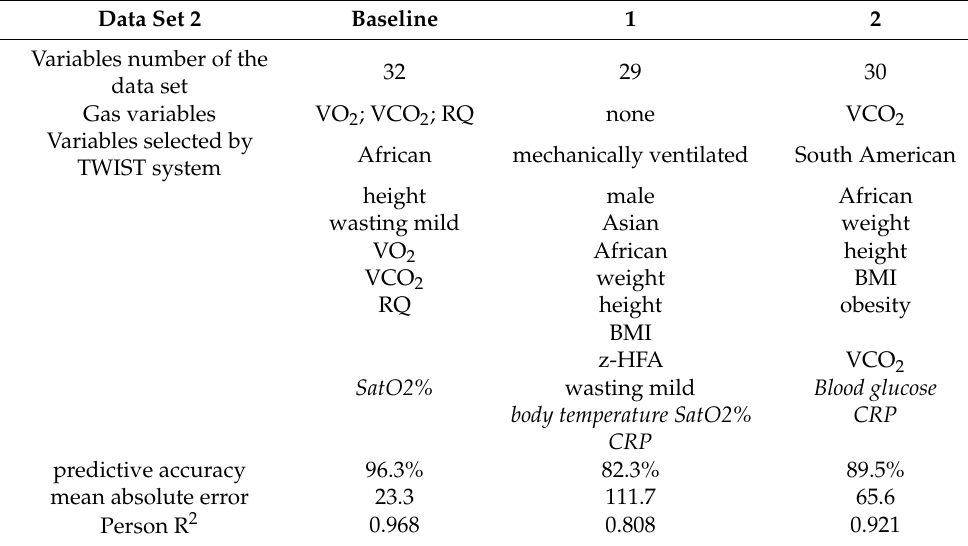
Table 6. Results obtained in the three differential analyses relevant to the role of gas